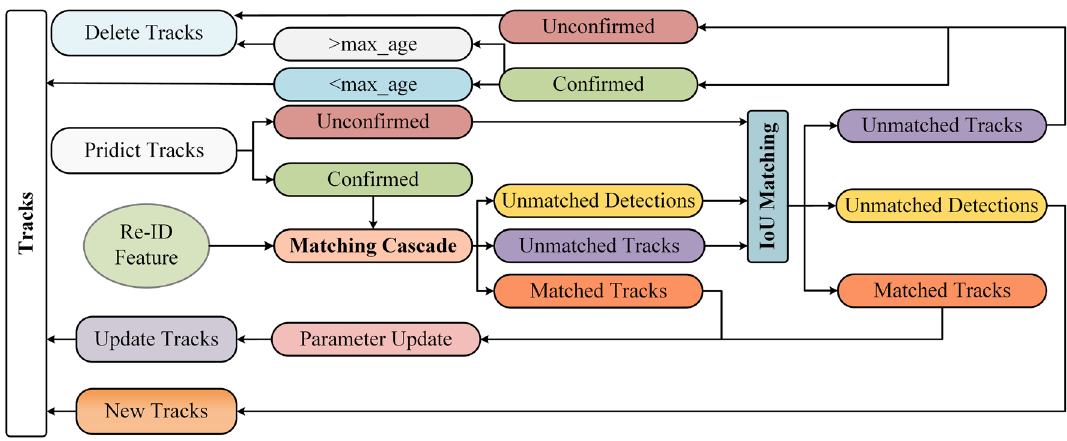
Figure 7. This is Tracking